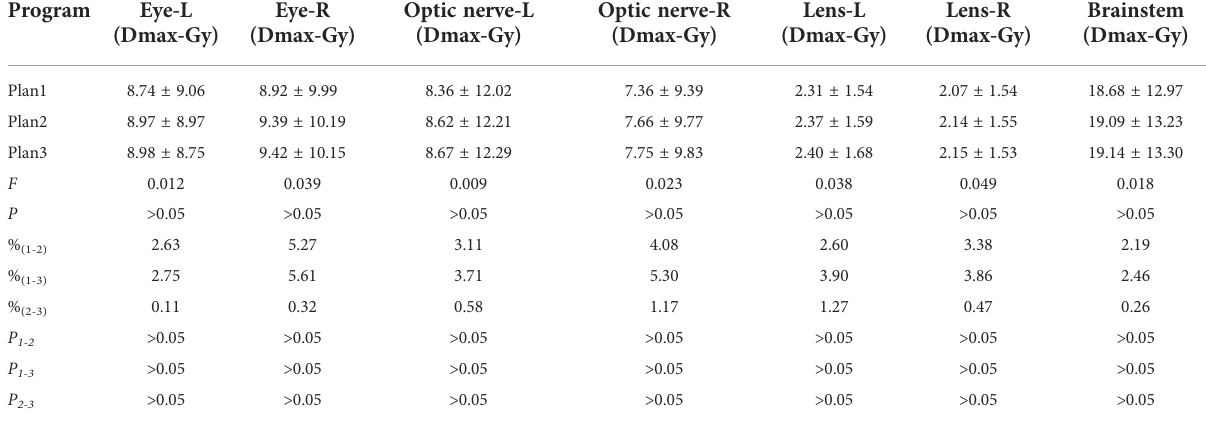
TABLE 4 Comparison of organs at risk among three plans.